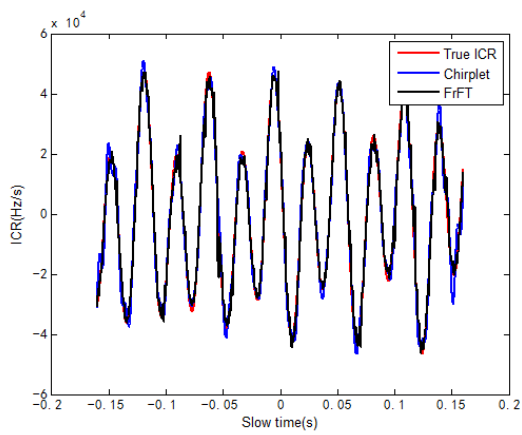
Figure 12. ICR estimation of the distributed imaging scene.